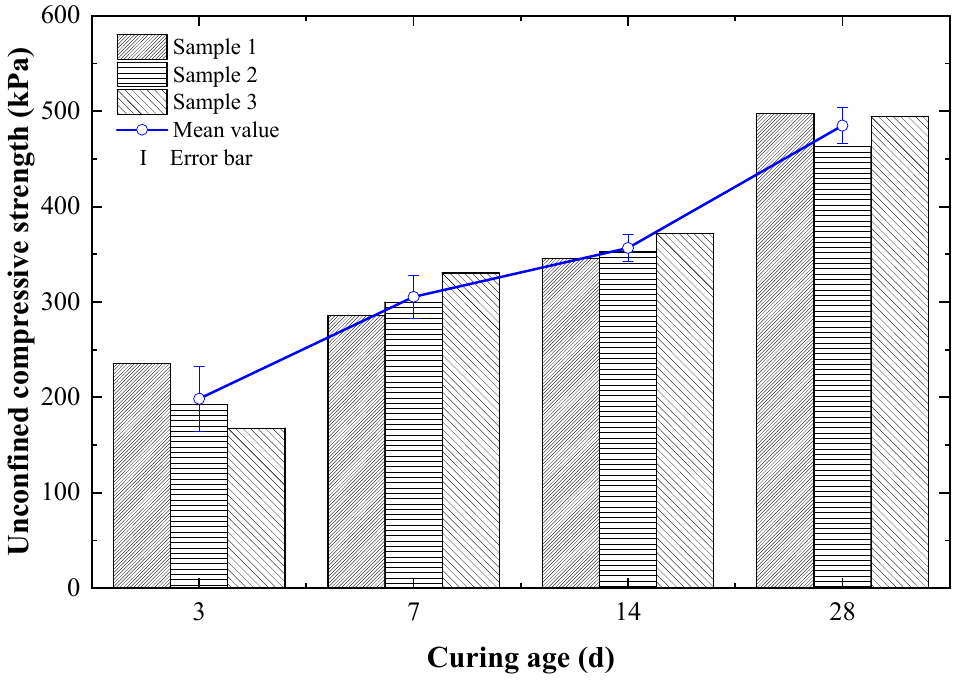
Figure 6. Compressive strength variations of cement- and steel-slag-stabilized dredged soils after different curing ages.